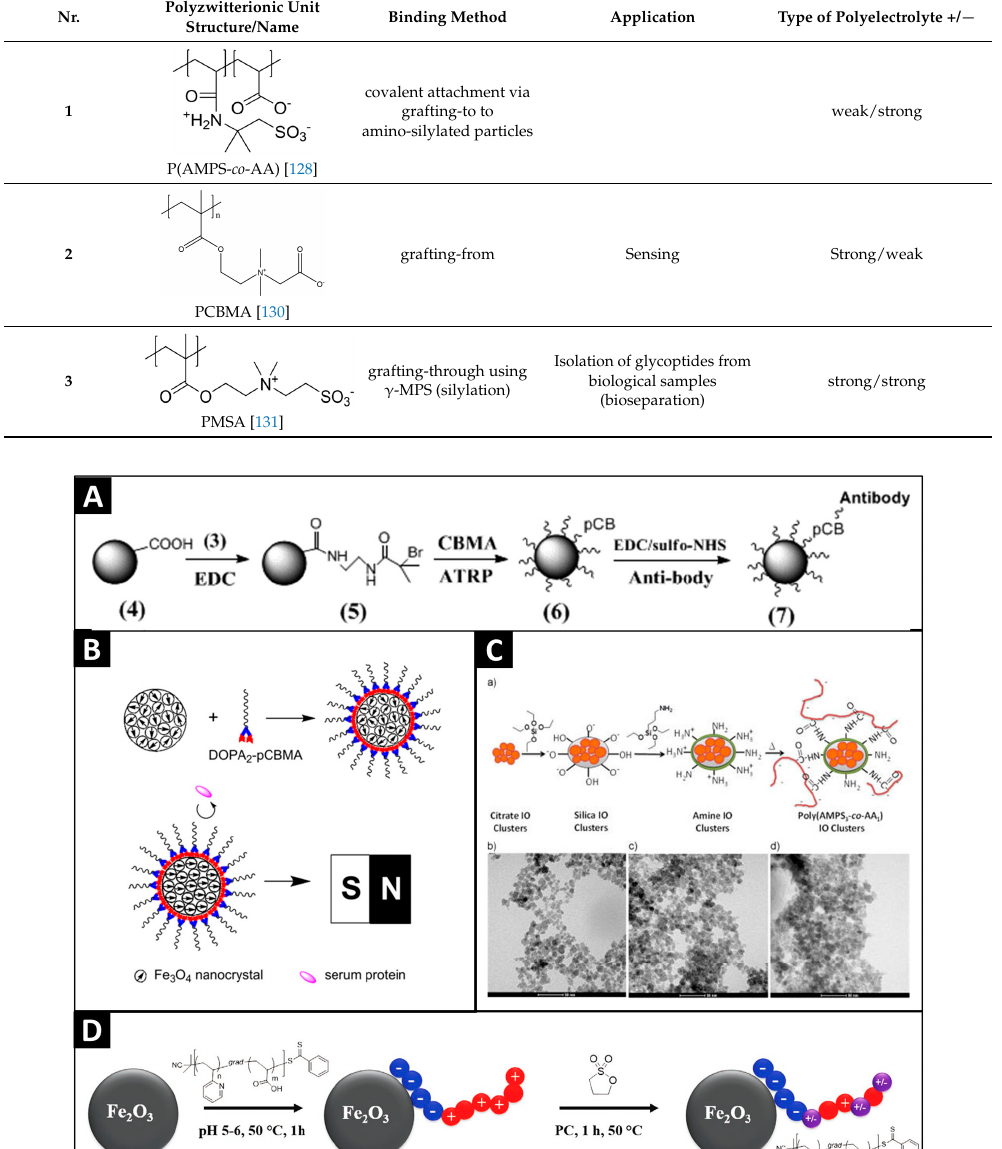
Table 1. Structures, binding method, potential application (if provided) and type of polyelectrolyte combination for polyzwitterions which were used for covalent surface functionalization of magnetic nanoparticles (MNP).